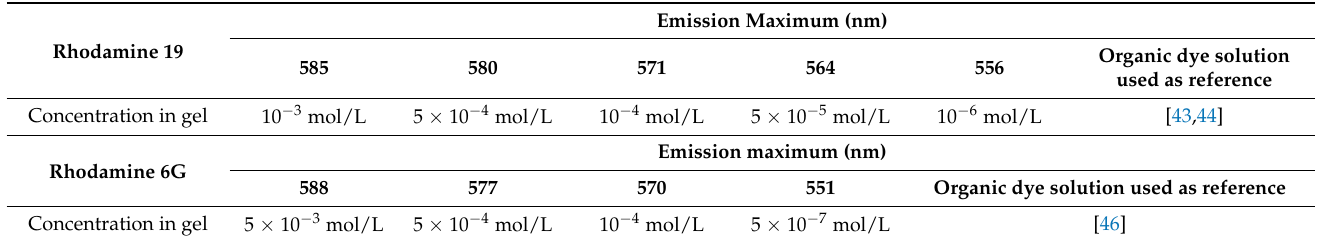
Table 1. Concluded concentration in gels based on the references in solutions and literature.